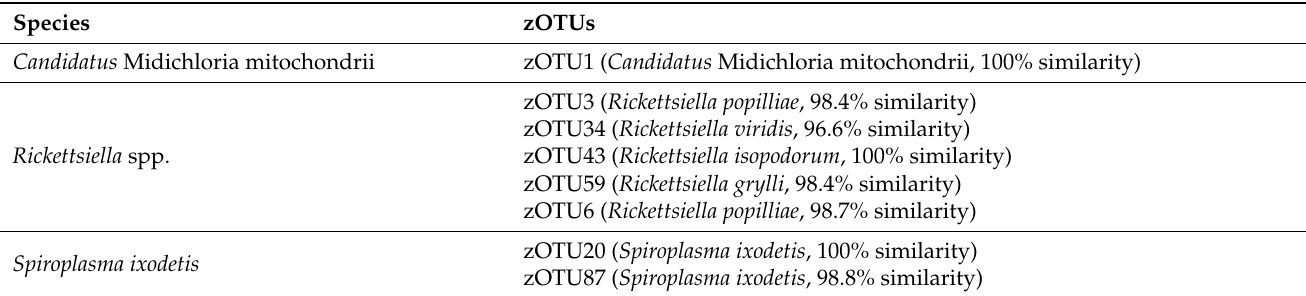
Table 2. Probable endosymbiotic species detected in Ixodes ricinus ticks and their assigned zOTUs. Species zOTUs